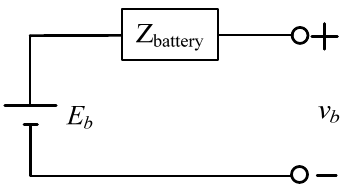
Figure 4. The Li-ion battery equivalent circuit model.